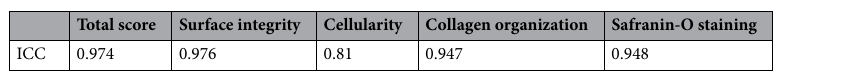
Table 1. Inter-rater intraclass correlation coefficient (ICC) in each histological